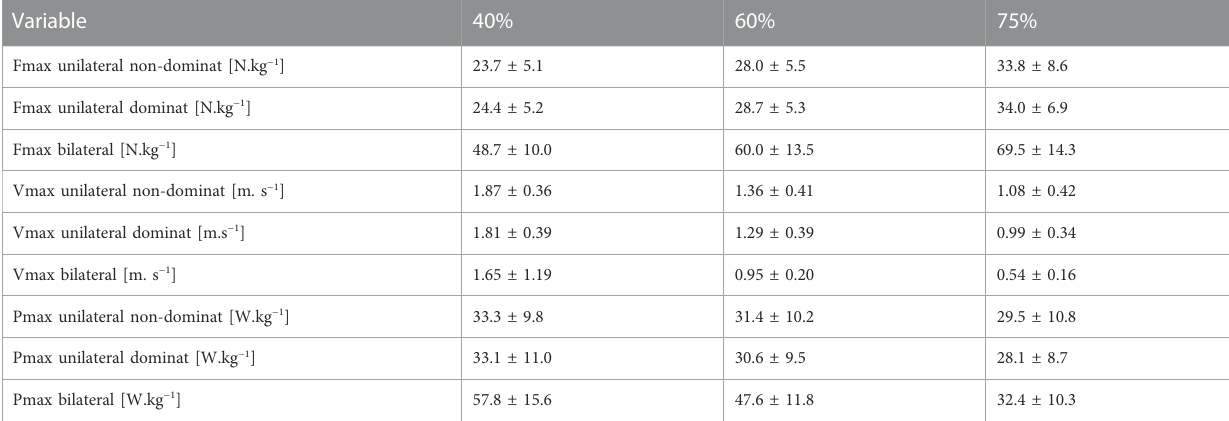
TABLE 1 Values of the variables analysed and results of comparison between the different load conditions. Variable